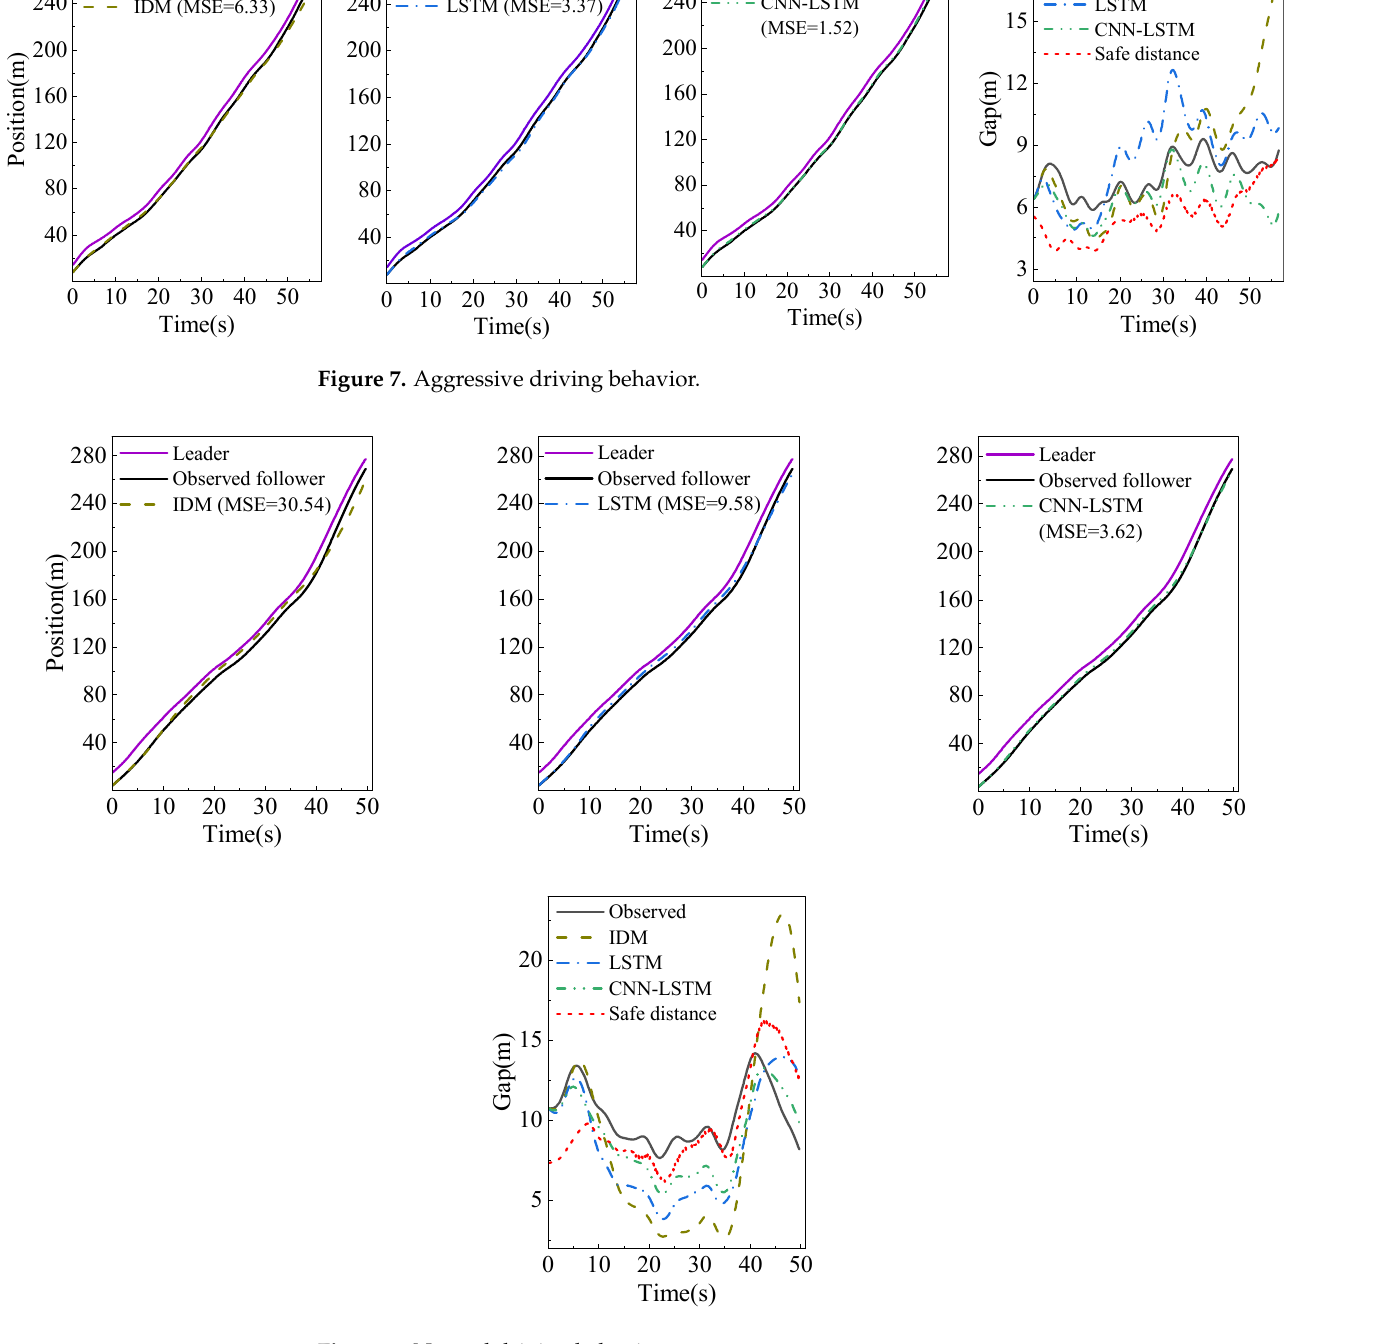
Figure 8. Normal driving behavior.